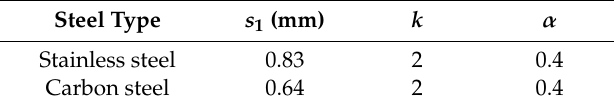
Table 3. Parameters of the proposed bond stress–slip